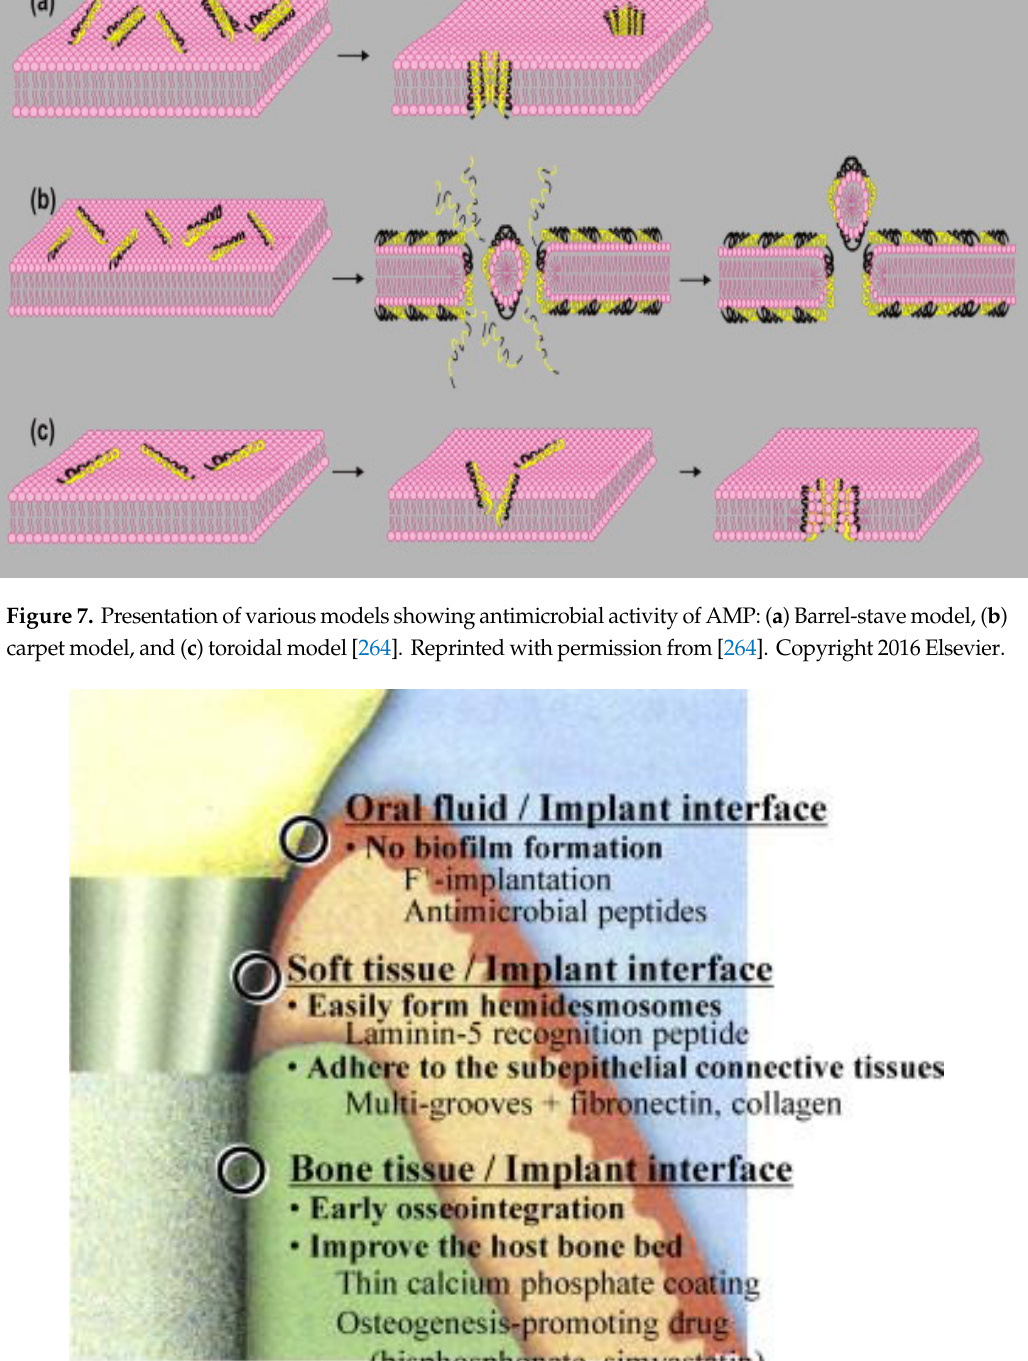
Figure 8. Bio-functionalization of dental implants with surface modification and various interfaces [271] Reprinted with permission from [271]. Copyright 2011 Elsevier . Reprinted with permission from [271]. Copyright 2011